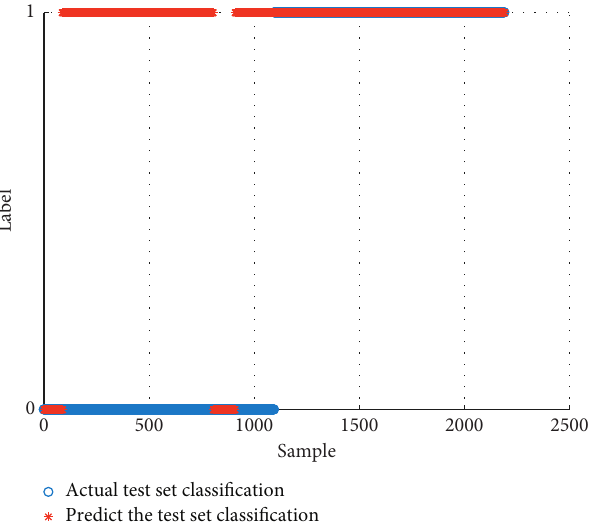
Actual test set classification Predict the test set classification Figure 5: Case Western Reserve University bearing inner ring failure results based on